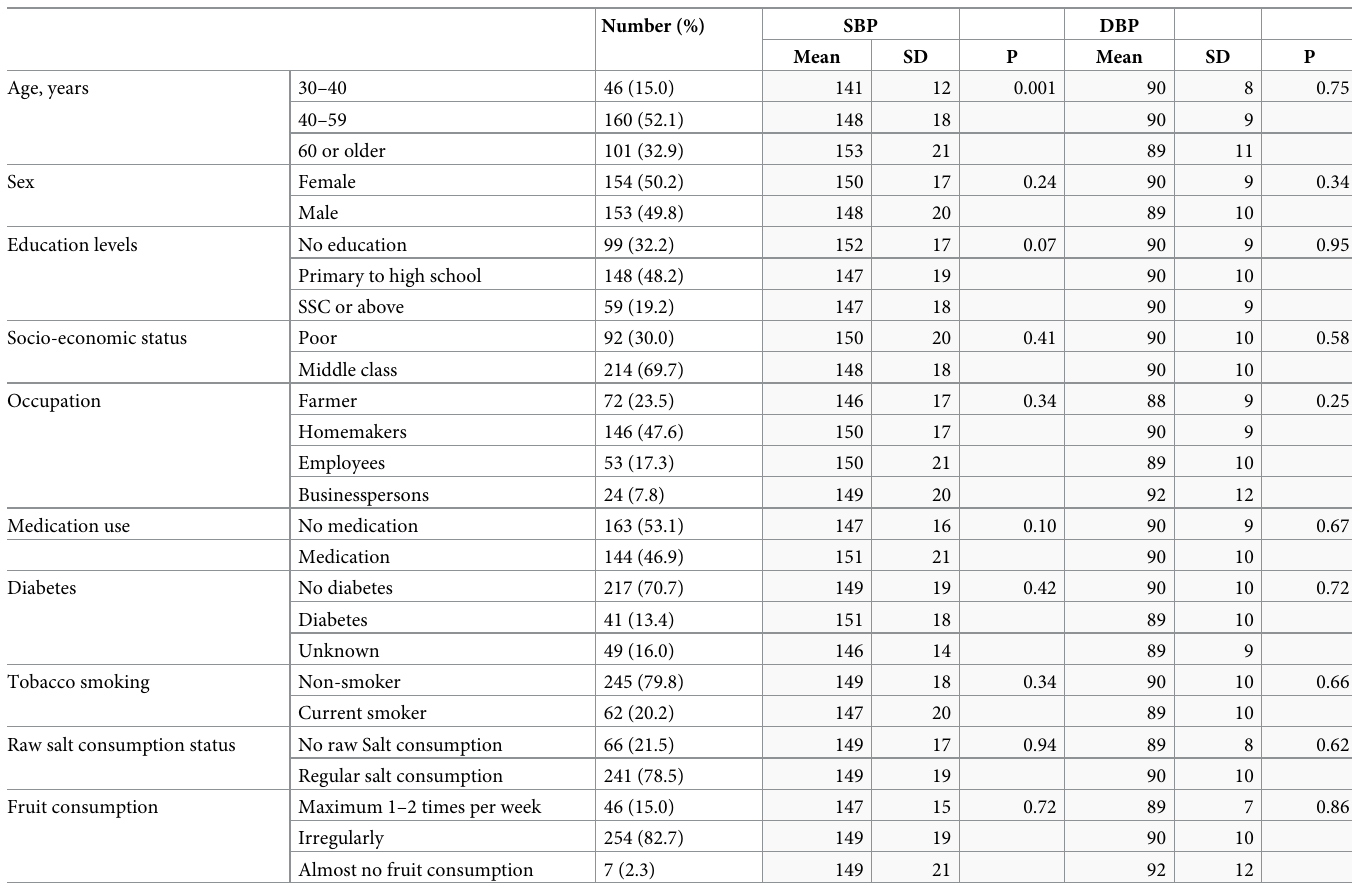
Table 1. Blood pressure by sociodemographic, behavioural and other